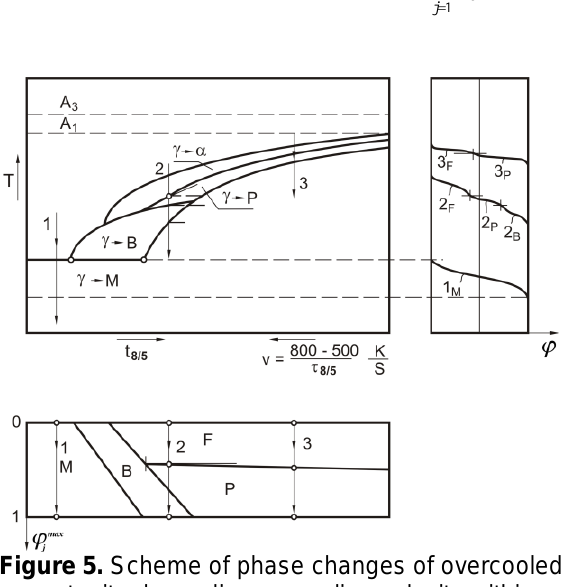
Figure 5. Scheme of phase changes of overcooled austenite depending on cooling velocity within temperature range 800-500 0